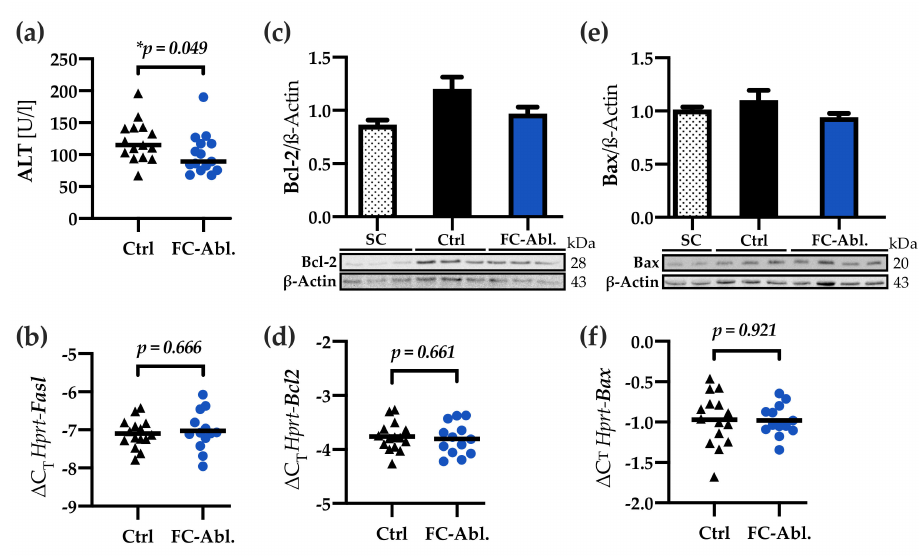
Figure5. Liverintegritywaspreservedbyfibrocyteablation. ( a )Fibrocyteablationcausedaconsiderable reduction in serum levels of alanine amino transferase (ALT). Median is depicted, Mann-Whitney U test was applied. ( b ) Quantitative real-time PCR showed an unchanged expression of Fasl. ( c ) Bcl-2 western blot and optical densitometry thereof hinted at a reduced expression of Bcl-2 in the fibrocyte-ablated group. Arbitrary unit. SC n = 5; Ctrl, FC-Abl. n = 6. ( d ) qPCR displayed an unchanged Bcl2 expression. ( e , f ) Bax is expressed comparably on a protein and transcriptional level in the control- and fibrocyte-ablated group. Arbitrary unit; SC n = 4; Ctrl n = 10; FC-Abl. n = 9; All western blot experiments were performed ≥ 2 times, representative blots are shown. Columns and error bars depict Mean + SEM.